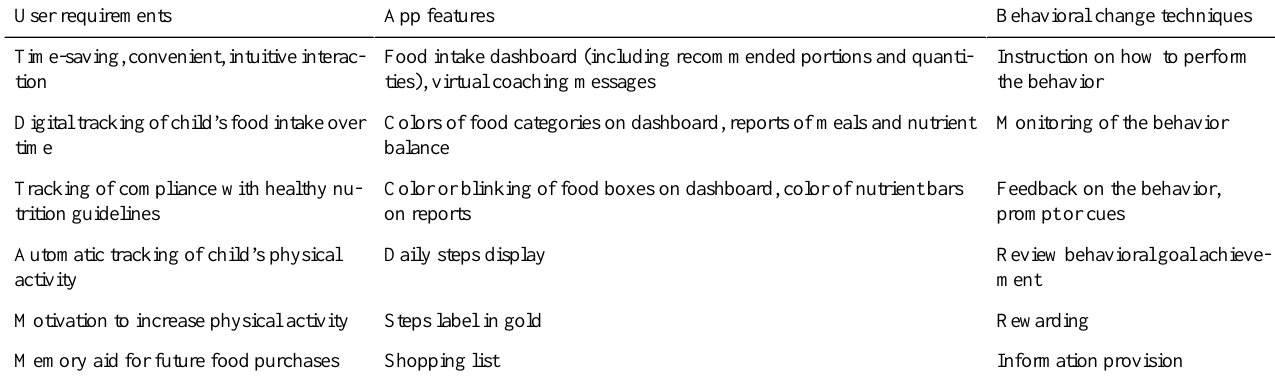
Table 1. Mapping of user requirements to TreC-LifeStyle app features and behavioral change